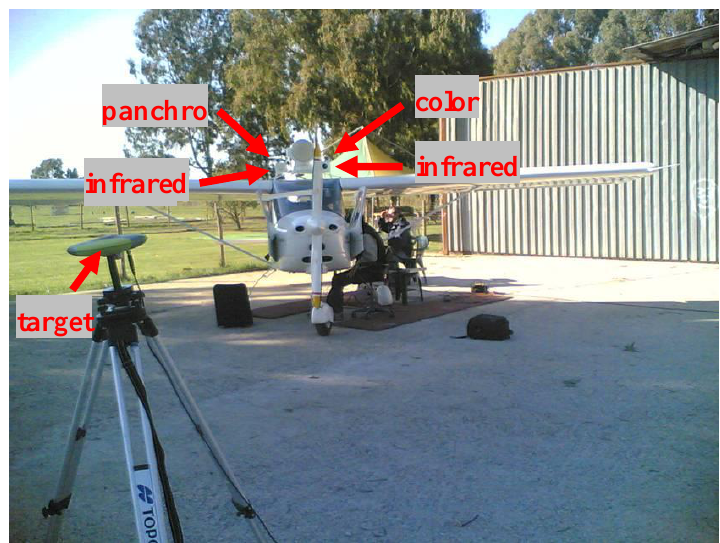
Figure 3. Calibration procedure: acquisition of target images and